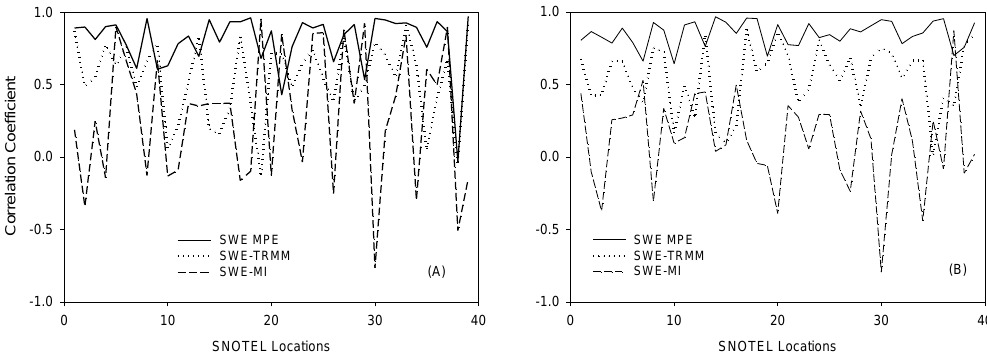
Fig. 6. Correlation coefficients between the average seasonal (A) SNODAS SWE at various grid resolutions and (B) the SWE recorded by the SNOTEL site at 39 sites in the upper Colorado Basin with the SWE estimate products from the MI imagery and UEB simulations.